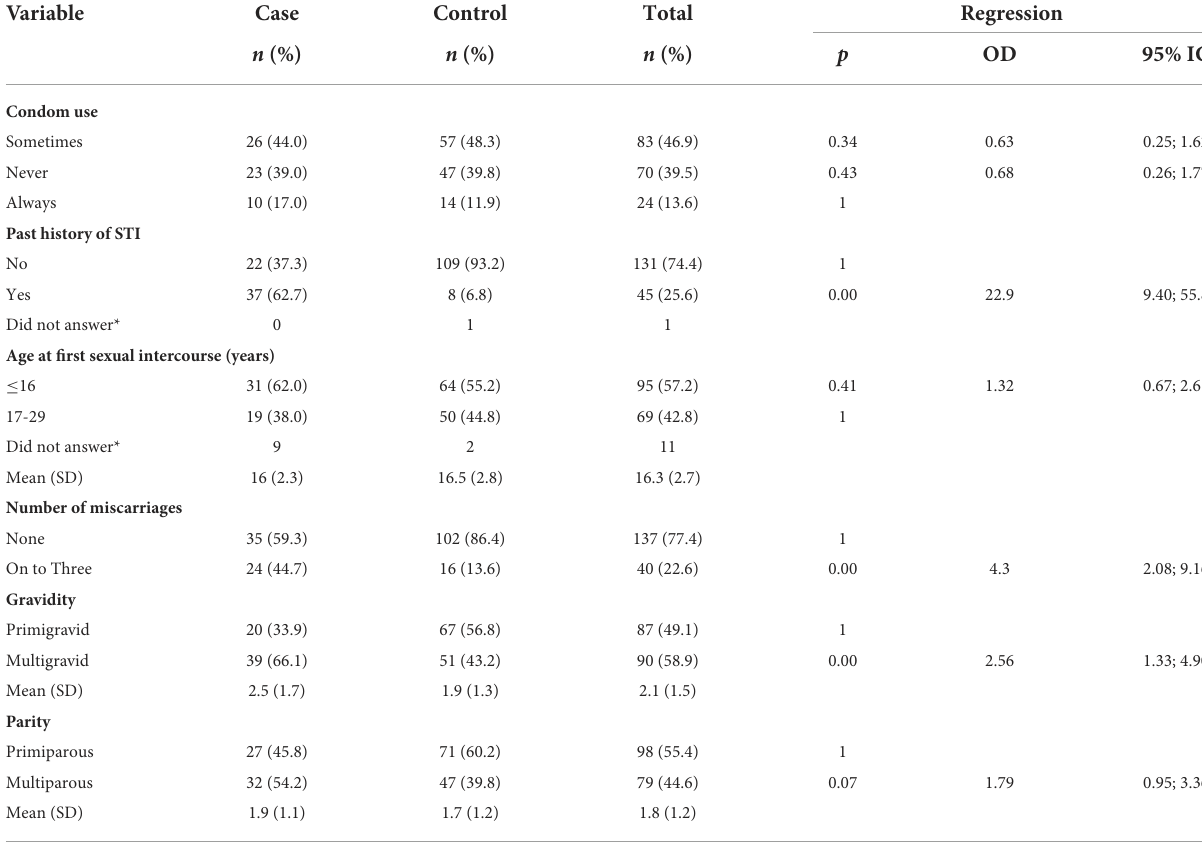
TABLE 3 Obstetrics and sexual factors associated with gestational syphilis, in the Brazilian Amazon, 2020–2021. Variable